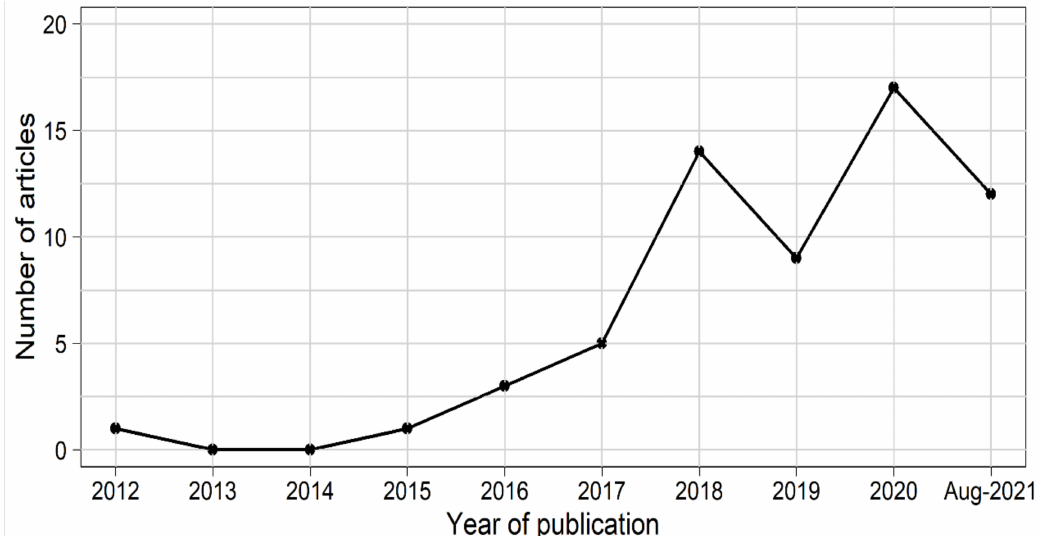
Figure 3. Year-wise number of papers